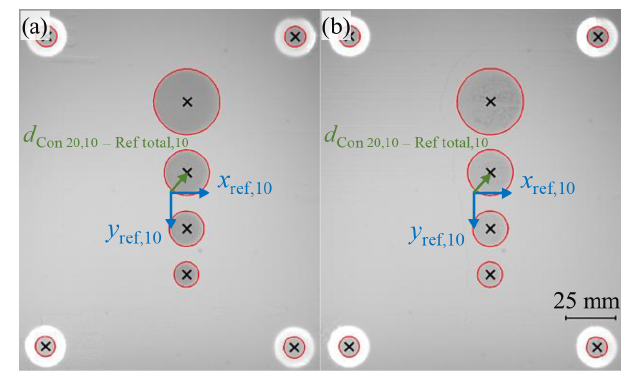
Figure 11. In situ edge detection of reference pipes and melting pool contours (a) after energy input of the laser and (b) after powder application for determination of centroids and referenced distance